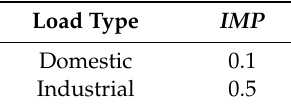
Table 4. Loads and their importance